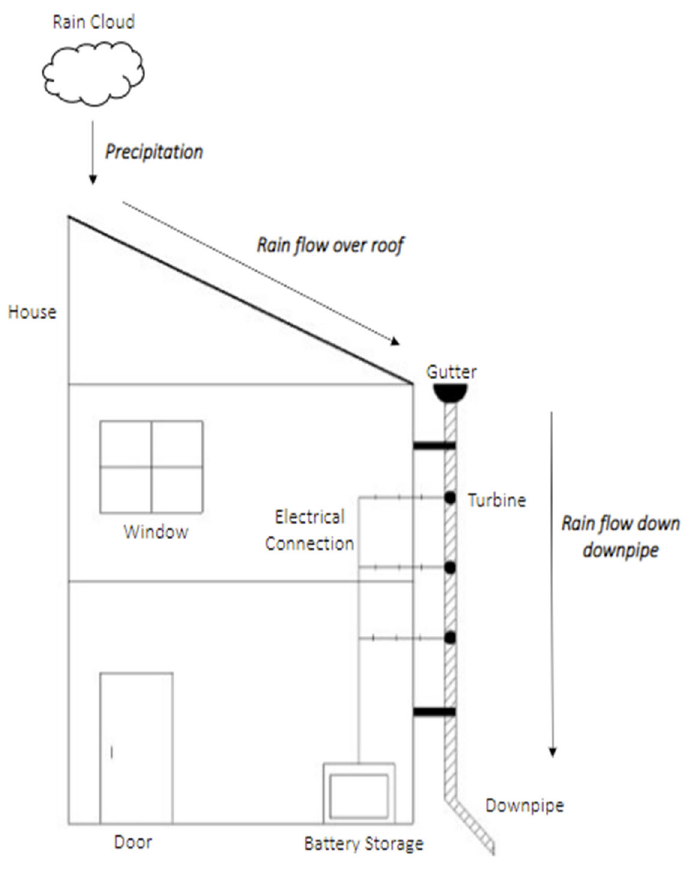
Figure 1. Home schematic of turbine series.